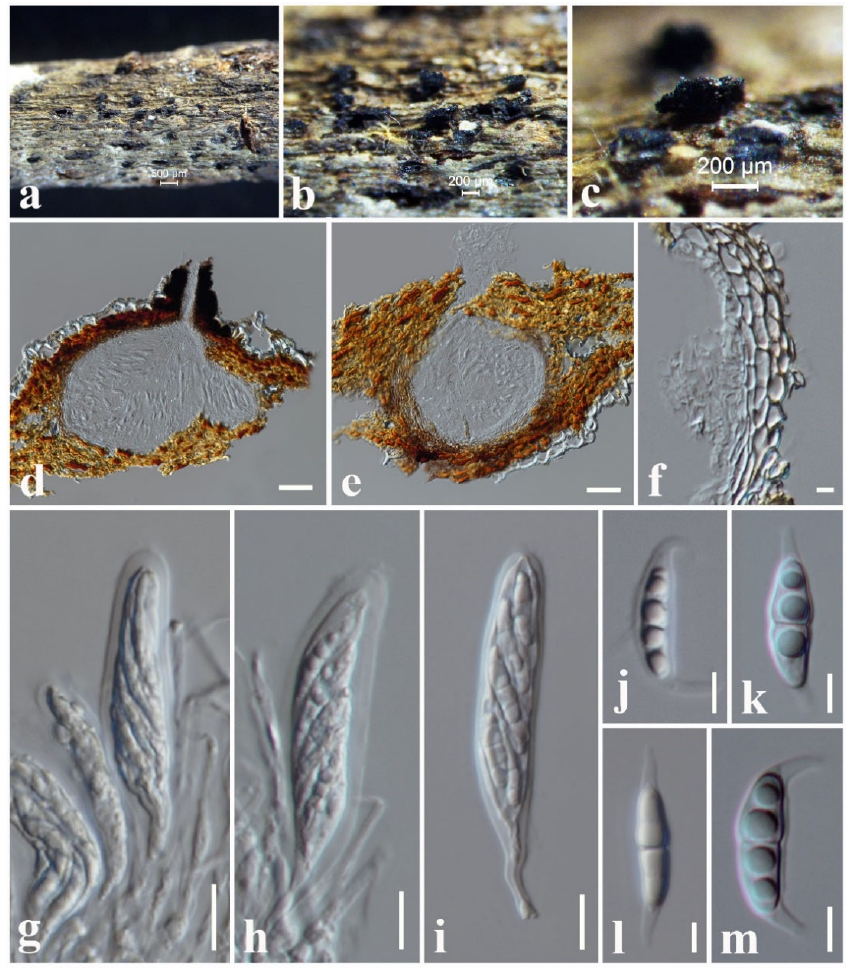
Figure 7. Leptoparies magnoliae (MFLU 18 ‐ 1291, holotype). ( a ) The specimen. ( b , c ) Appearance of